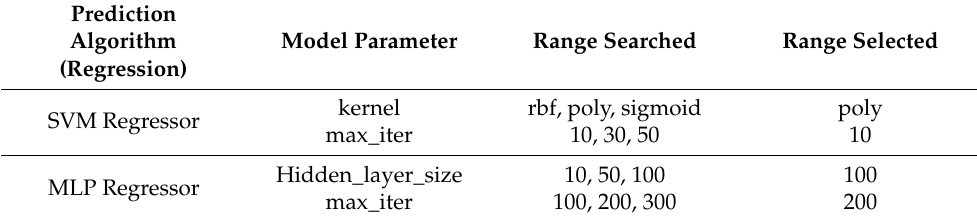
Table 2. Hyperparameter tuning for regression modelling.